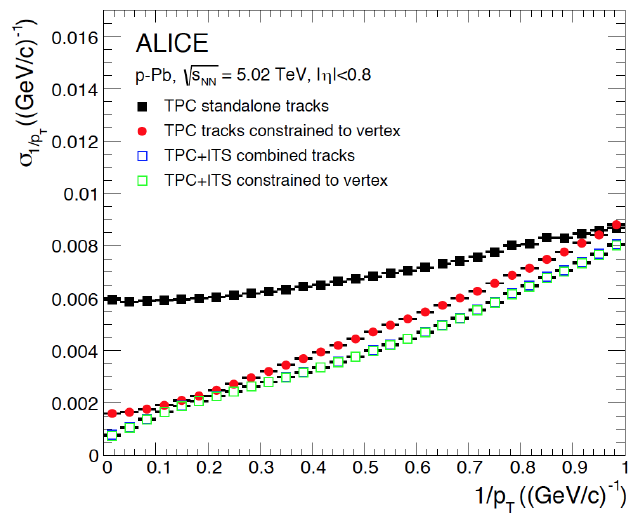
Figure 63. The black squares show the TPC stand-alone p T resolution in ALICE for p –Pb collisions. From Ref. [116].